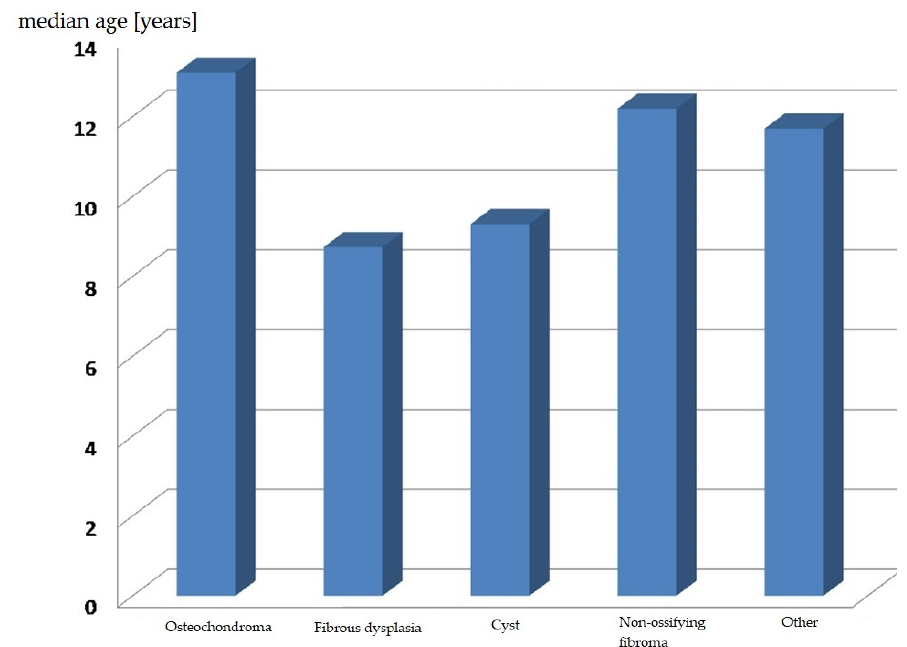
Figure 4. Age distribution in specific histopathological diagnoses.